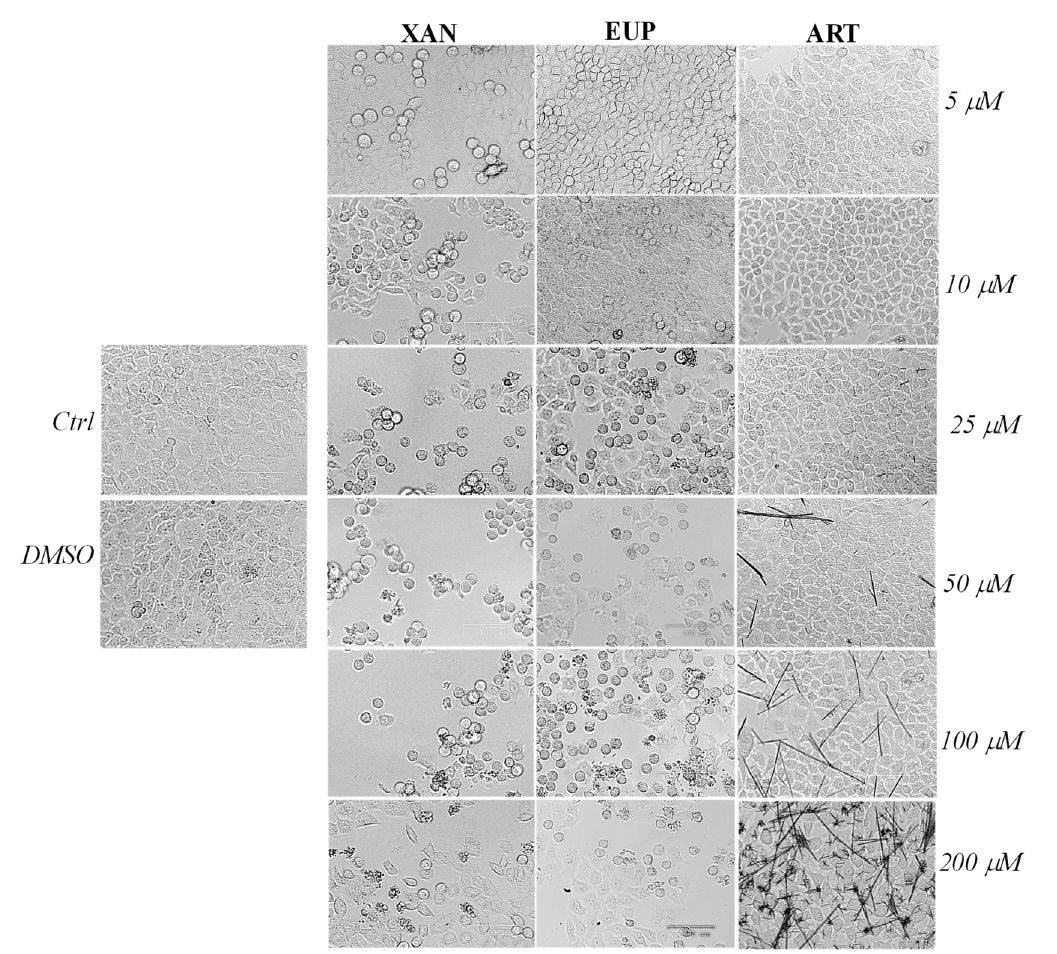
Figure 3. The panel shows representative images of phase contrast of control HeLa cells and cells treated for 24 h with xanthomicrol (XAN), eupatilin (EUP), and artemetin (ART) at 5–200 μ M. Bar = 100 μ m.